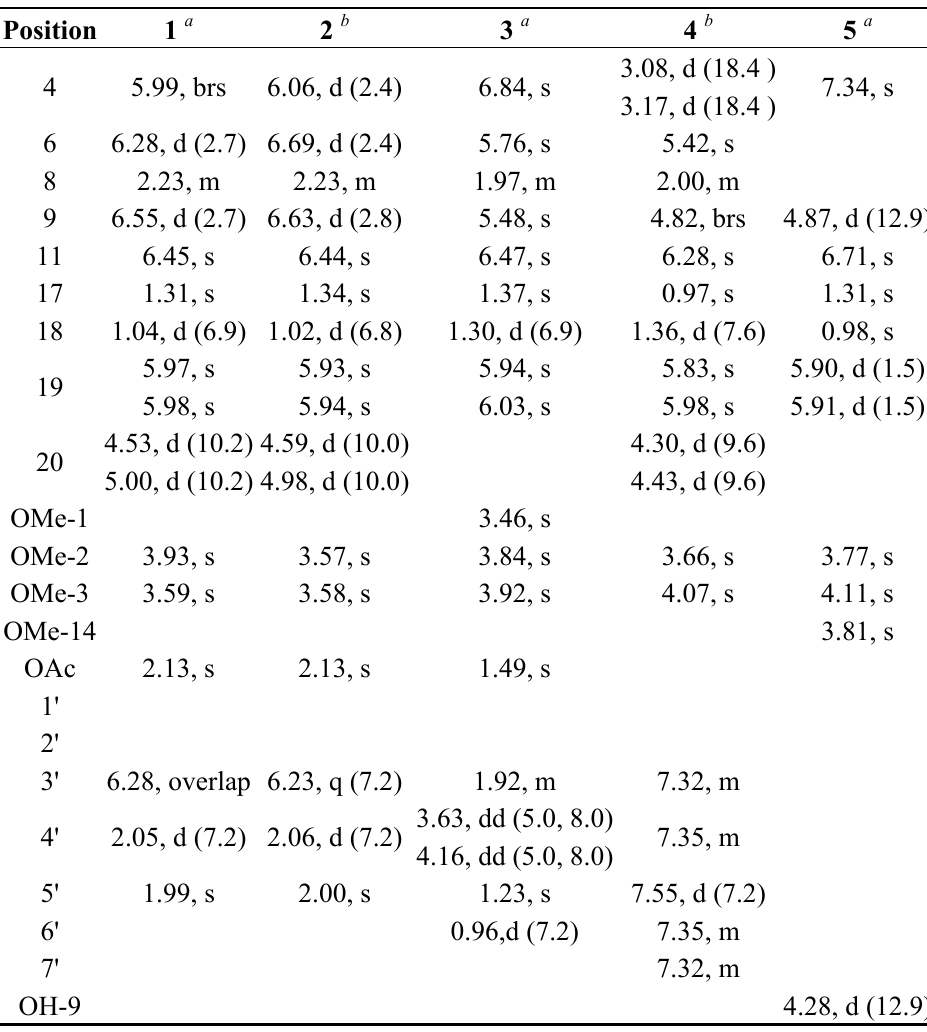
) of compounds 1 – 5 a,b 3